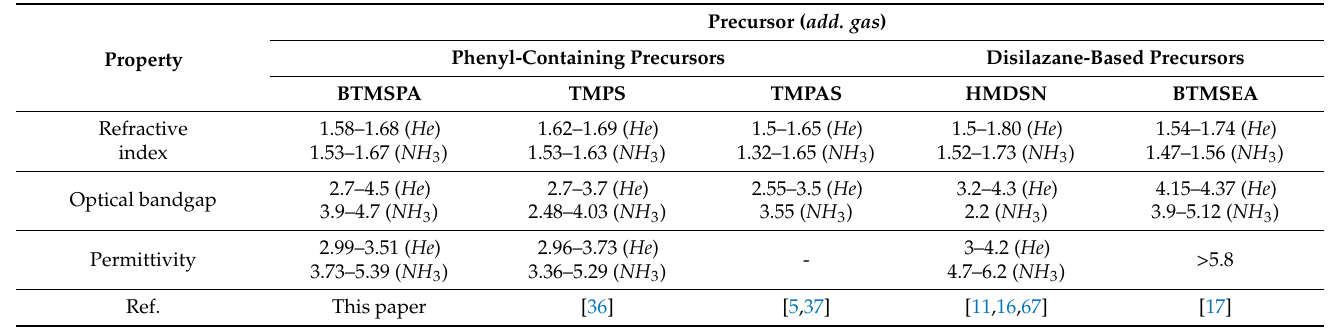
Table 1. Properties of the SiCN films deposited from various organosilicon precursors in a mixture with He or NH 3 using PECVD (data reported in the literature and present